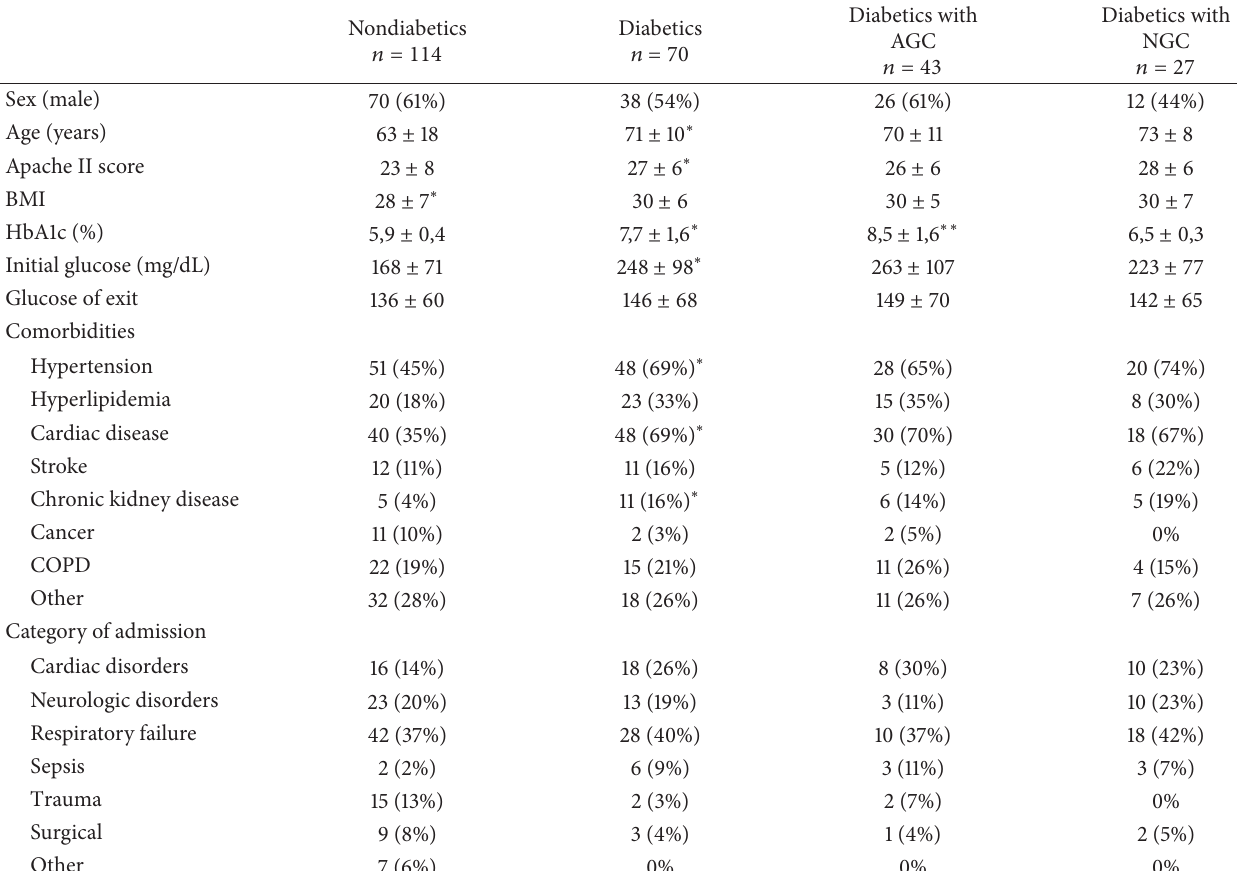
Table 1: Baseline characteristics of all study groups as determined by hemoglobin A1c (HbA1c) and